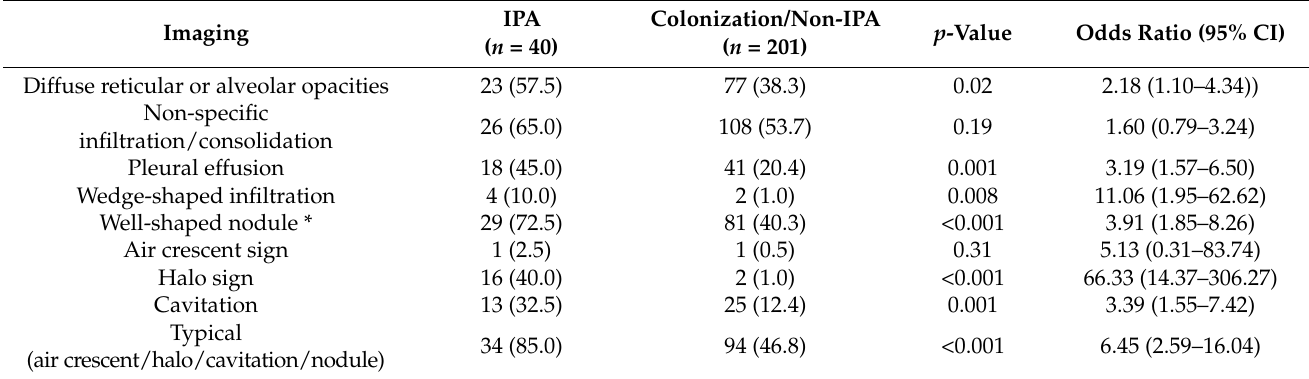
Table 5. Chest computed tomography (CT) or chest radiography compared between patients with invasive pulmonary aspergillosis (IPA) and patients with colonization or